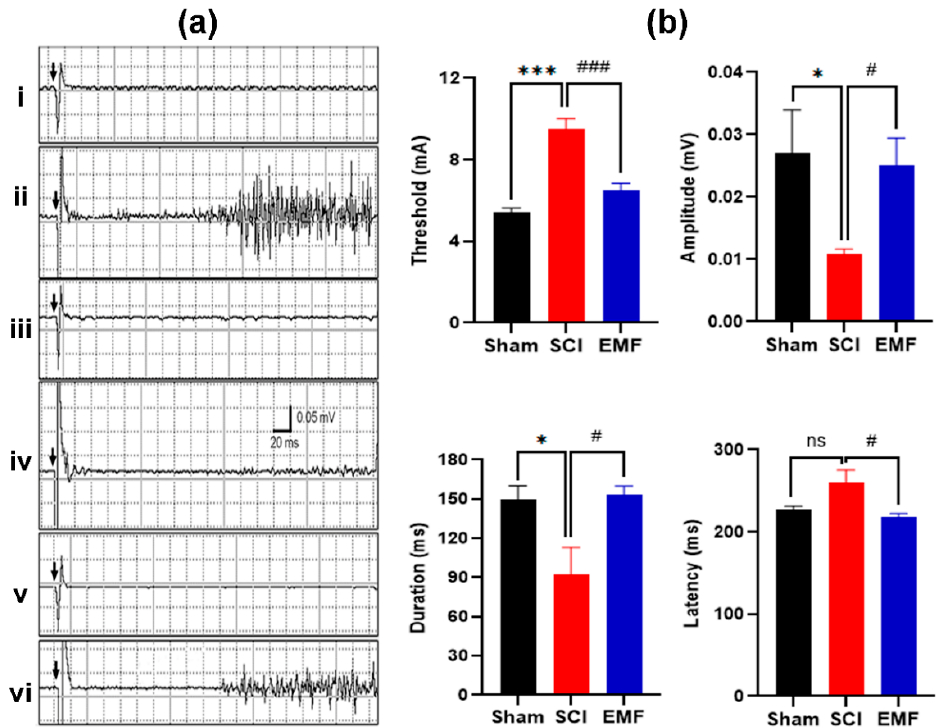
Figure 5. Effect of EMF stimulation on NFR after complete SCI. The representative graphs of NFR ( a ) in the Sham (i–ii, n = 7), SCI (iii-iv, n = 6), and EMF (v–vi, n = 6) groups. Graphs i, iii, and v (4.8, 9.8, 6.8 mA, respectively) show the stimulus artifact (black arrows), while ii, iv, and vi show the threshold for NFR in the Sham (5 mA), SCI (10 mA), and EMF (7 mA) groups. The right-side panel ( b ) shows the comparison of NFR parameters such as threshold, latency, amplitude, and duration. * indicates the comparison between the Sham and SCI/EMF groups, while ˆ indicates the comparison between the SCI and EMF groups. */ # p < 0.05 and ***/ ### p < 0.001.